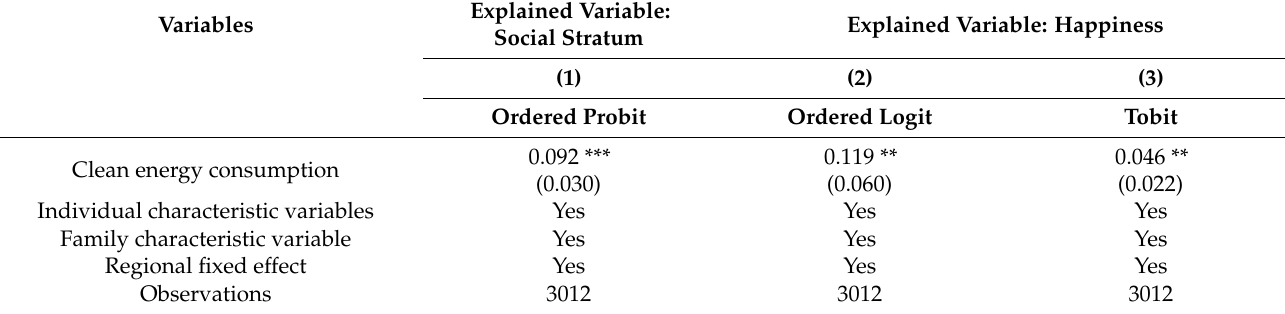
Table 6. Robustness check.